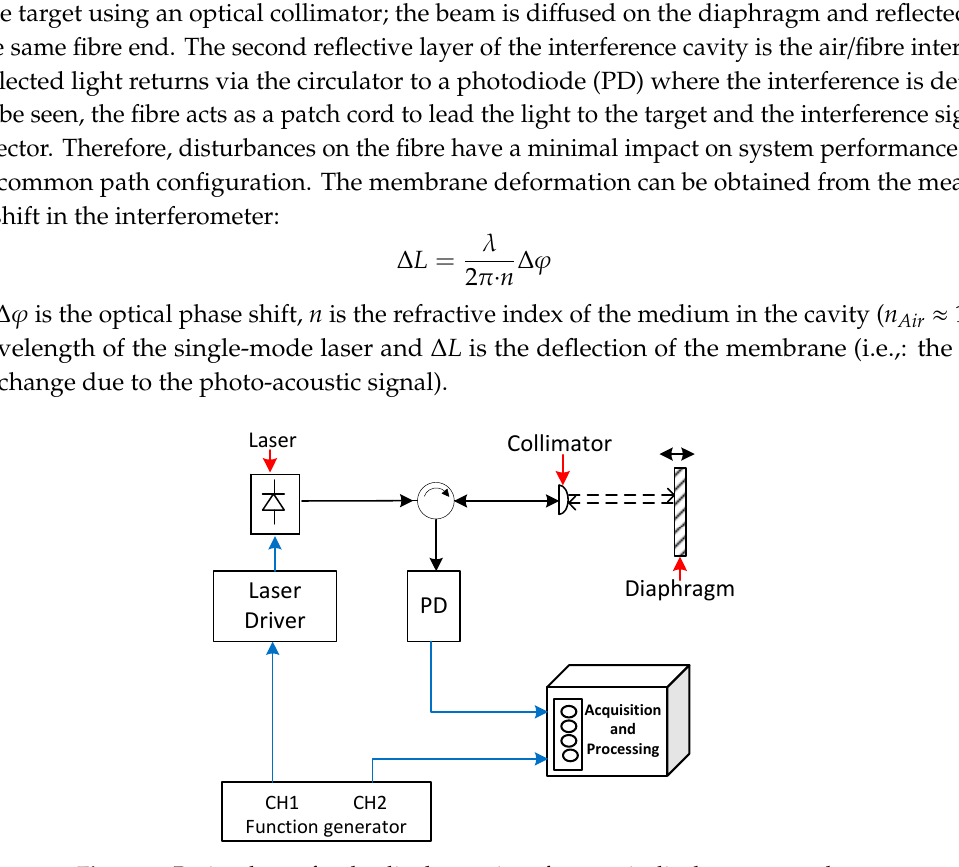
Figure 2. Basic scheme for the diaphragm interferometric displacement readout.